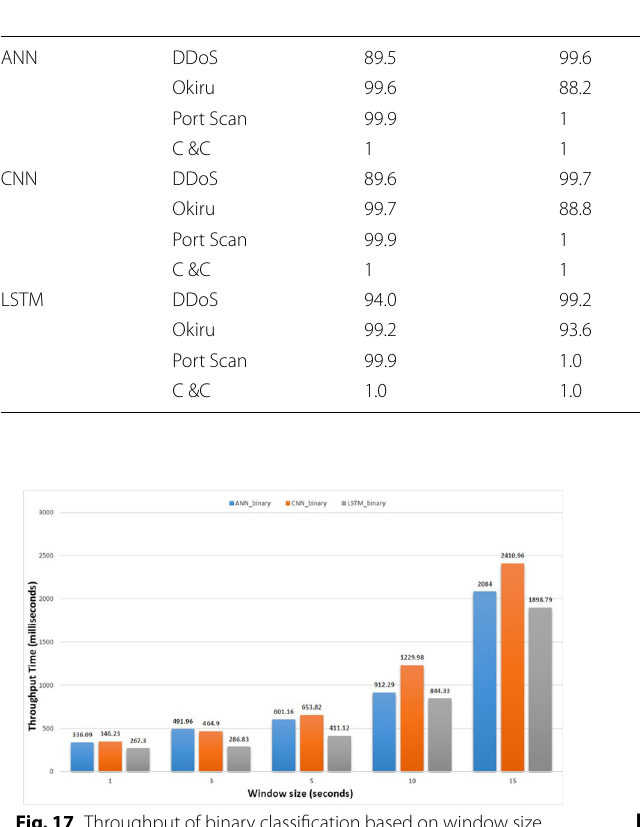
Table 7 Results for attack only data—attack classification in batch mode Model